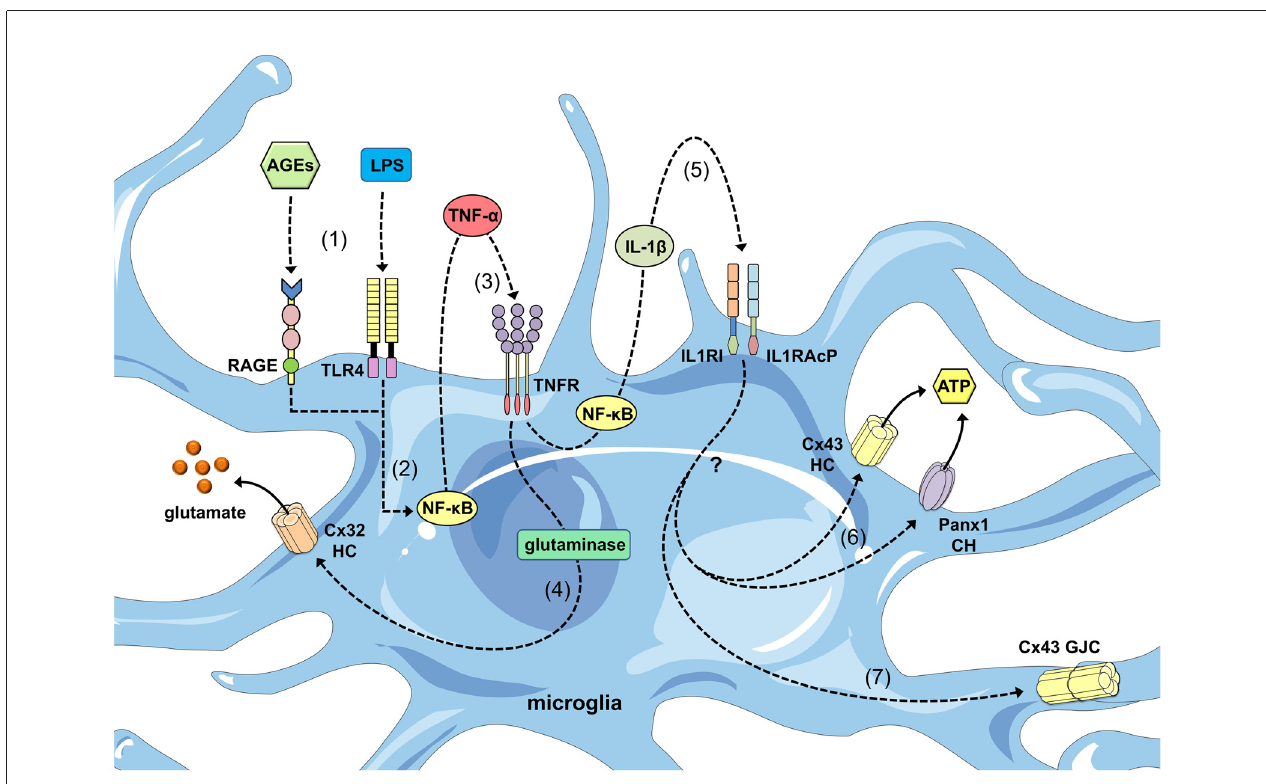
FIGURE 2 | Regulation of connexin- and pannexin-based channels by cytokines released from activated microglia. Advanced glycation end-products (AGEs) and lipopolysaccharide (LPS) stimulate the receptor for age (RAGE) and Toll-like receptor 4 (TLR4) receptors (1), respectively, resulting in activation of the nuclear factor- κβ ; (NF- κβ ) pathway (2). This pathway induces the autocrine/paracrine release of tumor necrosis factor- α ; (TNF- α ), which acts upon its receptor TNFR1 (3) and leads to the activation of glutaminase and the further release of glutamate through Cx32 HCs (4). In parallel, NF- κβ signaling promotes the autocrine/paracrine release of interleukin-1 β ; (IL-1 β ), which acts upon its receptor as well as accessory proteins (IL1RI and IL1RAcP; 5) and leads to the release of ATP through Cx43 HCs and Panx1 channels (CHs) via an unknown mechanism (6). Additionally, IL-1 β signaling favors the opening of GJCs composed of